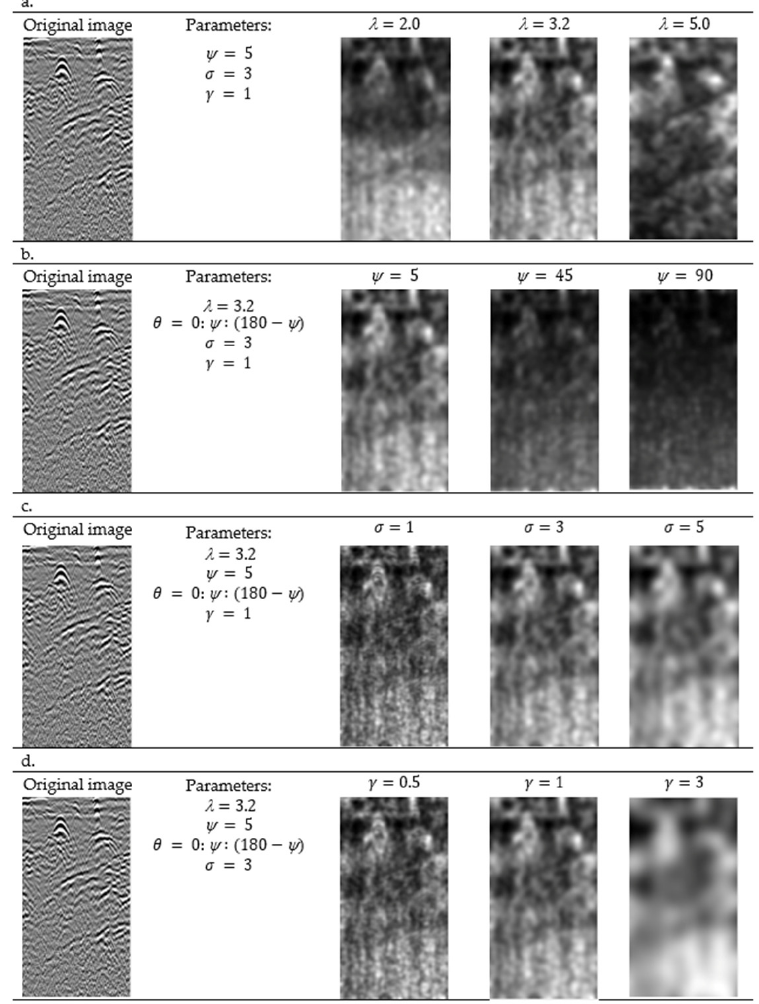
Figure 9. The variations of parameters in the shape of the Gabor function: ( a ) parameter λ ; ( b ) parameter Ψ ; ( c ) parameter σ ; ( d ) parameter γ .